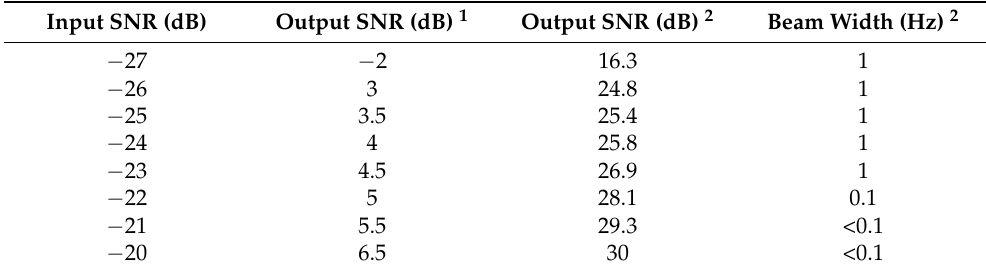
Table 1. Influence of input SNR on output SNR and width of